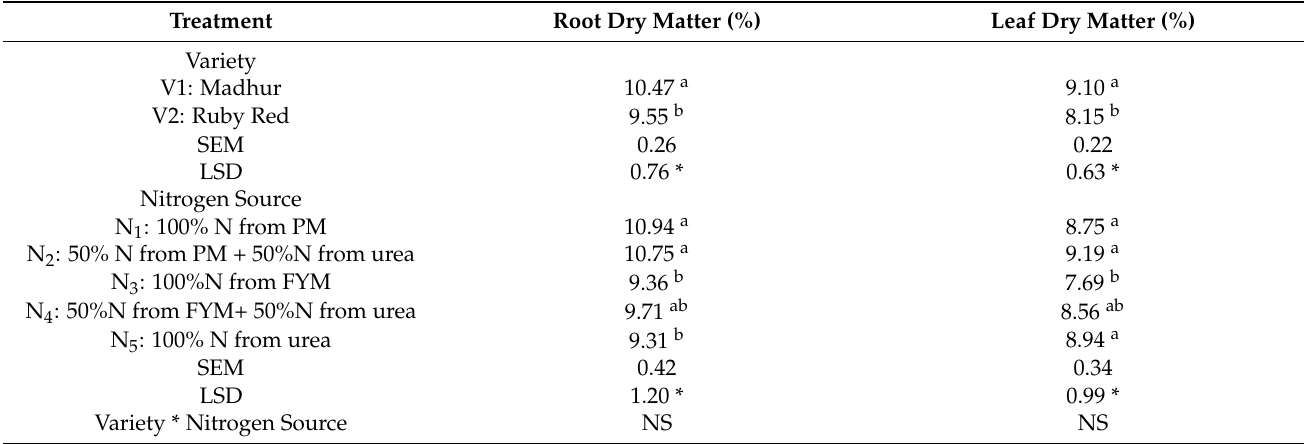
Table 9. Effect of varieties and nitrogen sources on root dry matter % and leaf dry matter of beetroot at AFU, Rampur, Chitwan in 2018/19.